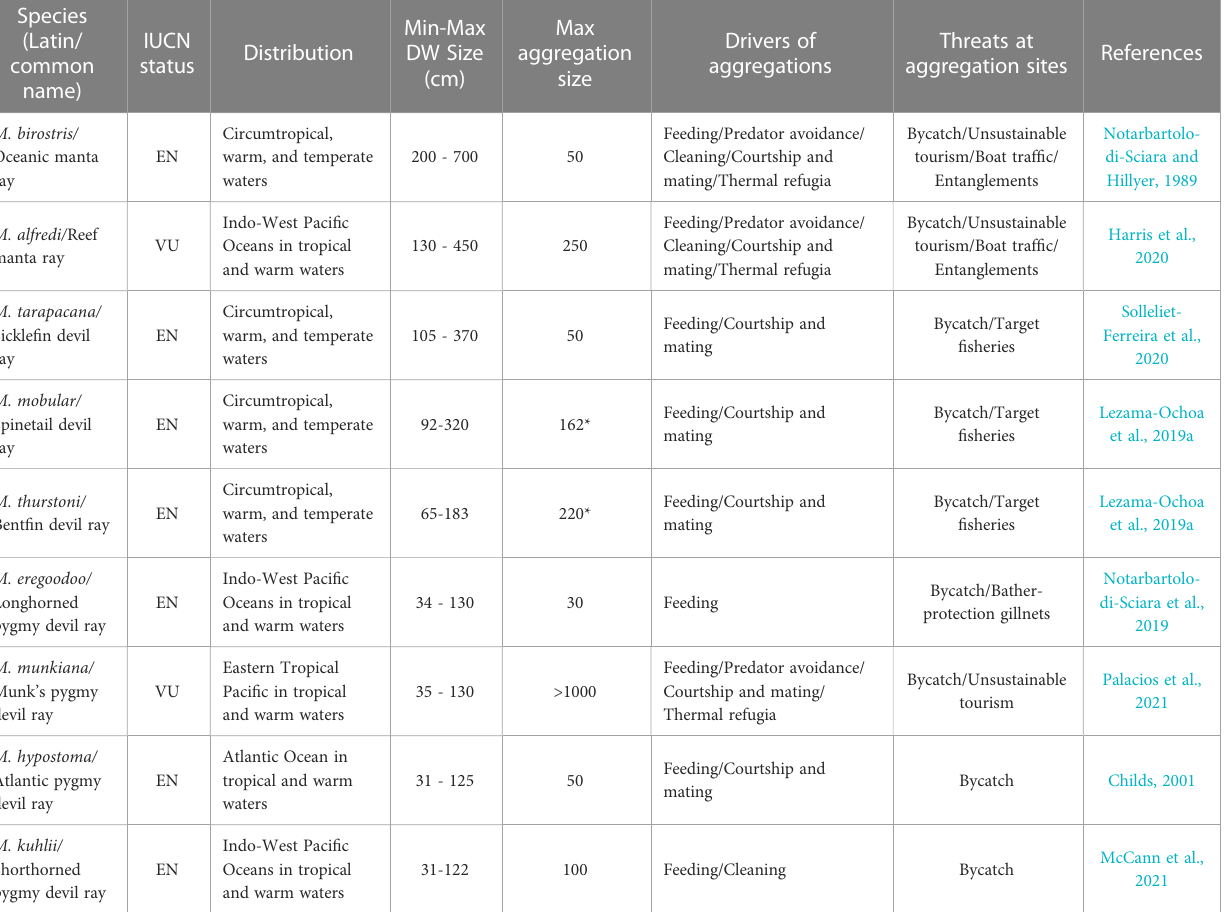
TABLE 1 Grouping behavior for mantas and devil rays. Species (Latin/